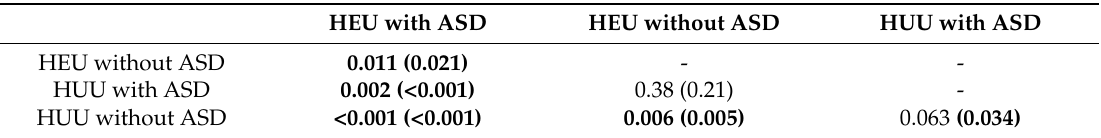
Table 3. p -Values for pairwise comparisons of mtDNA content between groups (calculated via Dunn’s post-hoc procedure following Kruskal-Wallis analysis of variance). HEU with ASD HEU without ASD HUU with ASD HEU without ASD 0.011 (0.021) - - - 0.063 (0.034)